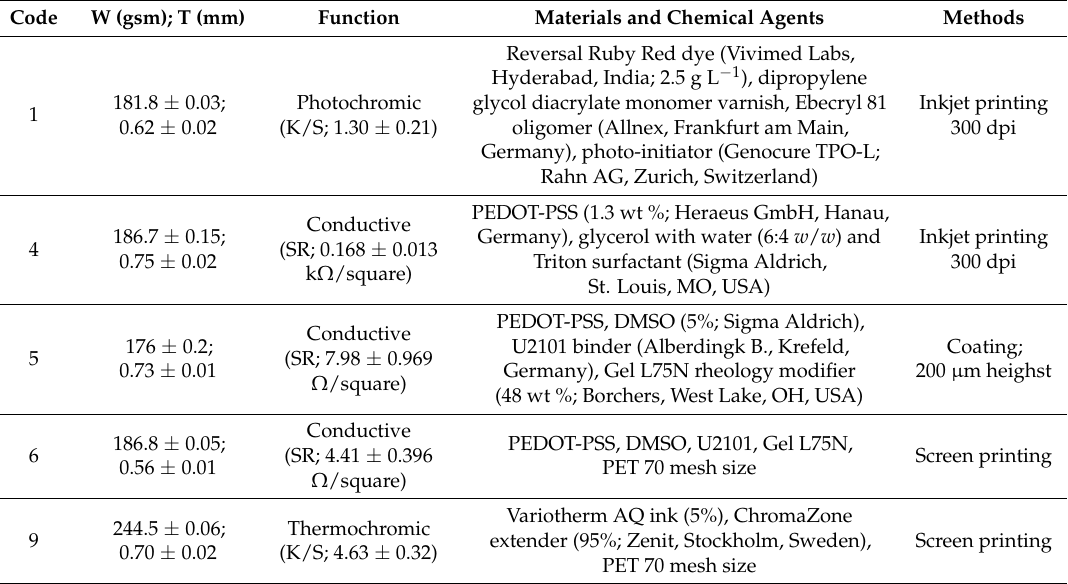
Table 1. The fabric samples and their production